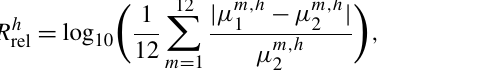
Figure 3. Variability analysis calculated for CO for MOD RANDPATH , MOD RANDLOC and MOD regular HrelTP = − 1km (1km below the tropopause). The timescales used to calculate R var using Eq. (5) are indicated by vertical